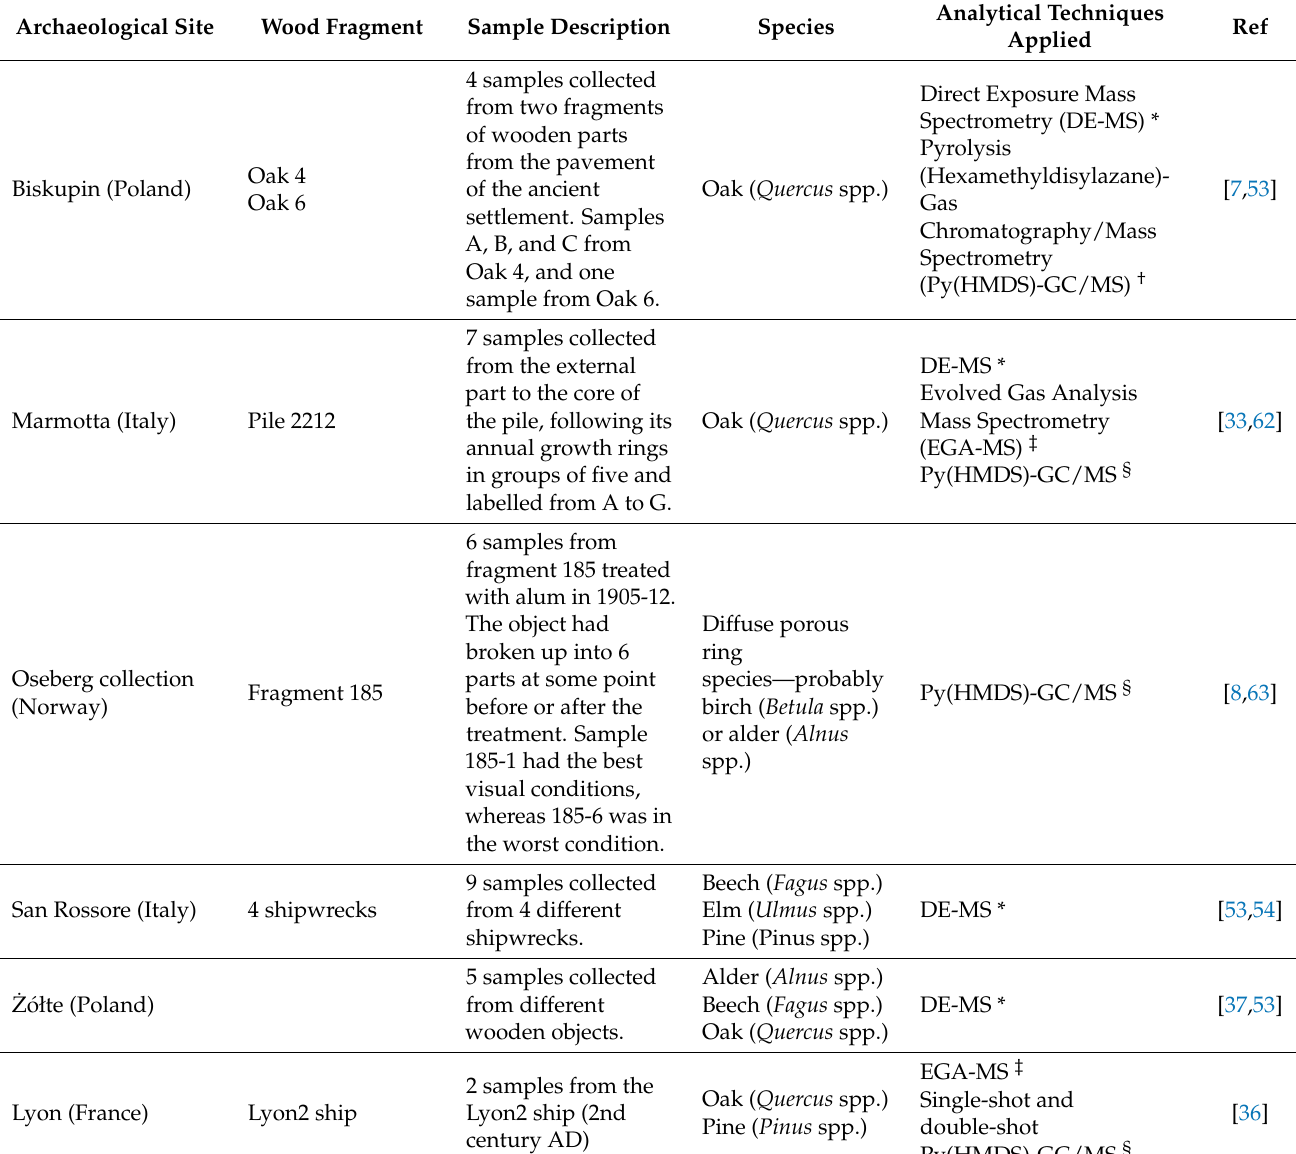
Table 1. The archaeological wood samples and analytical techniques used to obtain the data discussed. Samples were dried in oven at 40–50 ◦ C for 24 h and milled before